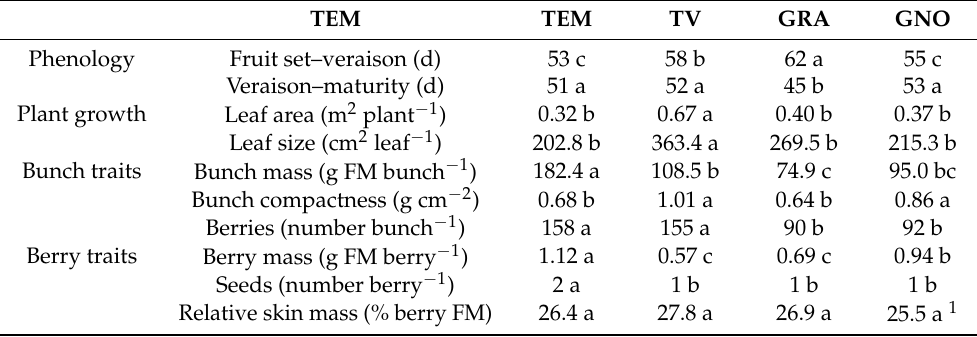
Table 2. General characteristics of fruit-bearing cuttings of different ancient wine grape varieties grown either at ambient (AT) or elevated temperature (ET) and subjected to different irrigation regimes (FI, full irrigation; DI, deficit irrigation). The variety labels can be found in Table 1. TEM TEM TV GRA GNO